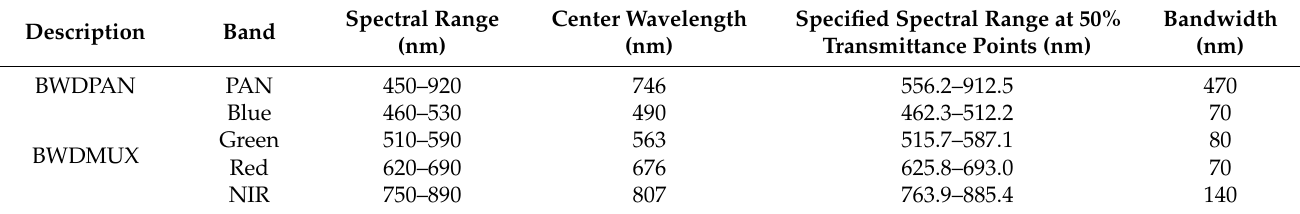
Table 2. The spectral response properties of the GF-7 BWD.